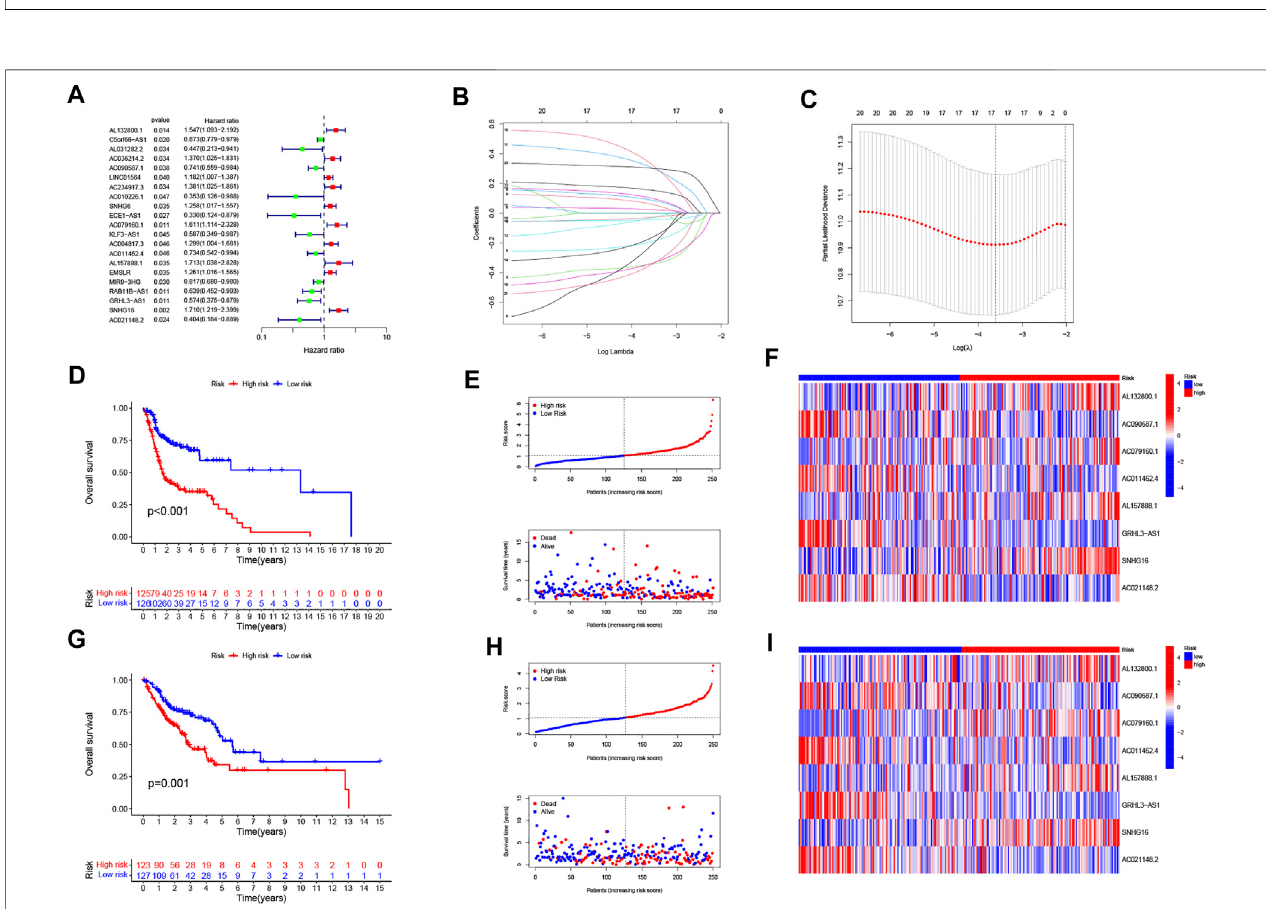
FIGURE2| Constructionoftheprognosticcuproptosis-relatedlongnoncodingRNA(lncRNAs)riskmodelinheadandnecksquamouscellcarcinoma(HNSC). (A) univariate Cox regression analysis for identifying the prognostic cuproptosis-related lncRNAs. (B – C) Lasso – Cox regression analysis was performed to construct prognosticpredictionmodels. (D) Kaplan – Meiercurvesforsurvivalanalysisinthehigh-andlow-riskgroups. (E) riskscoredistributionandsurvivalstatusinpatientswith HNSC. (F) heatmap of the prognostic markers and overall survival. (G) Kaplan – Meier curves for survival analysis in the validation cohort. (H) risk score distribution and survival status in the validation cohort. (I) heatmap of the prognostic markers and overall survival in the validation cohort.